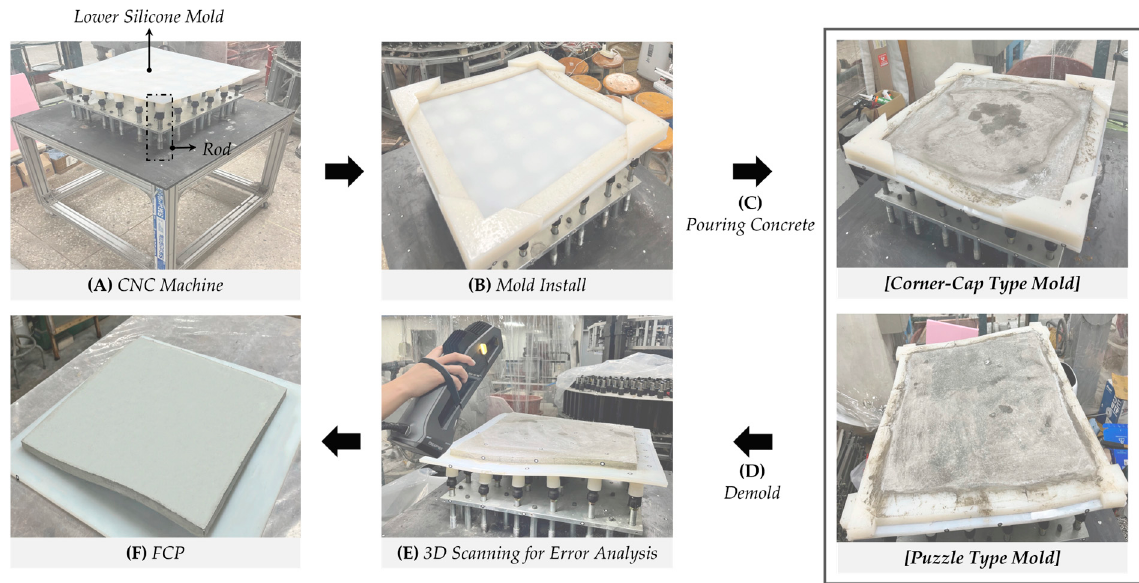
Figure 6. Experiment Process of FCP Fabrication.